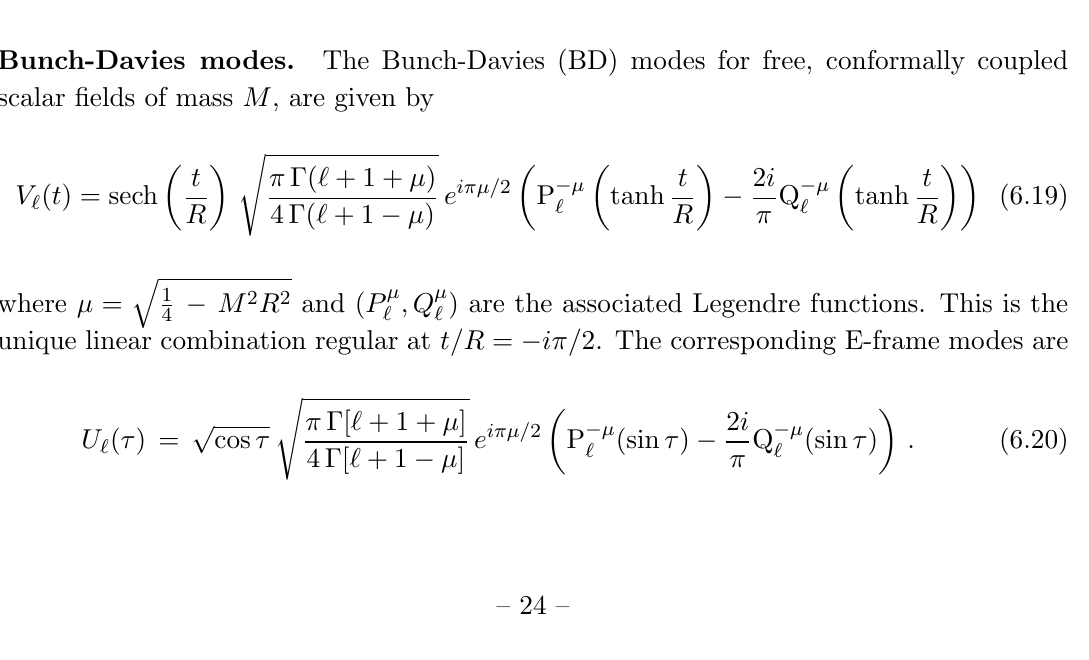
= (cid:0) 2 =R 2 ren